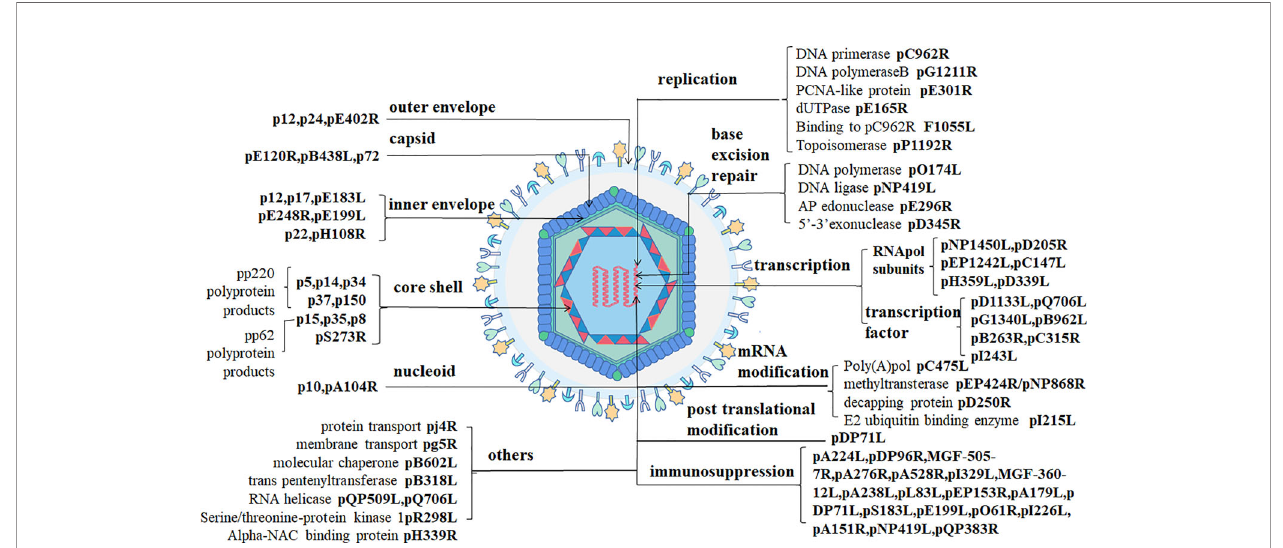
FIGURE 1 | ASFV structure (1). ASFV-encoded structural proteins constitute the envelope (p12/p24/pE402R), the capsid (pE120R/pB438L/p72), and the inner envelope (p12/p17/pE183L/pE248R/pH108R/pE199L/p22). p5, p14, p34, p37, and p150 are pp220 hydrolysates produced by pS273R. p15, p35, and p8 are p62 hydrolysates. DNA-binding proteins include pA104R and p10. ASFV-encoded proteins with clear functions include those involved in viral DNA replication (pC962R/ pG1211R/pE301R/pE165RF1055L/pP1192R), base excision repair (pO174L/pNP419L/pE296R/pD345R), transcription (pNP1450L/pD205R/pEP1242L/pC147L/ pH359L/pD339L/pD1133L/pQ706L/pG1340L/pB962L/pB263R/pC315R/pI243L), mRNA modi fi cation (pC475L/pEP424R/pNP868R/pD250R/pI215L), post-translational modi fi cation (pDP71L), immunosuppression (pA224L/pDP96R/MGF-505-7R/pA276R/pA528R/pI329L/MGF-360-12L/pA238L/pL83L/pEP153R/pA179L/pDP71L/ pS183L/pE199L/pO61R/pI226L/pA151R/pNP419L/pQP383R), and other proteins